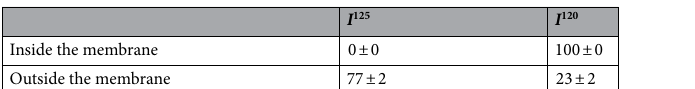
Table 1. Relative signal intensities of valine residues at 125 ppm ( I 125 ) and 120 ppm ( I 120 ) shown in Fig. 3b and c. Mean values ± standard from three independent